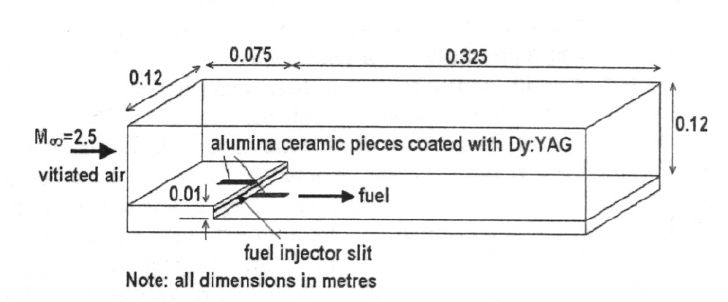
Figure 64. Schematic of a supersonic combustor test using thermographic phosphors [33].